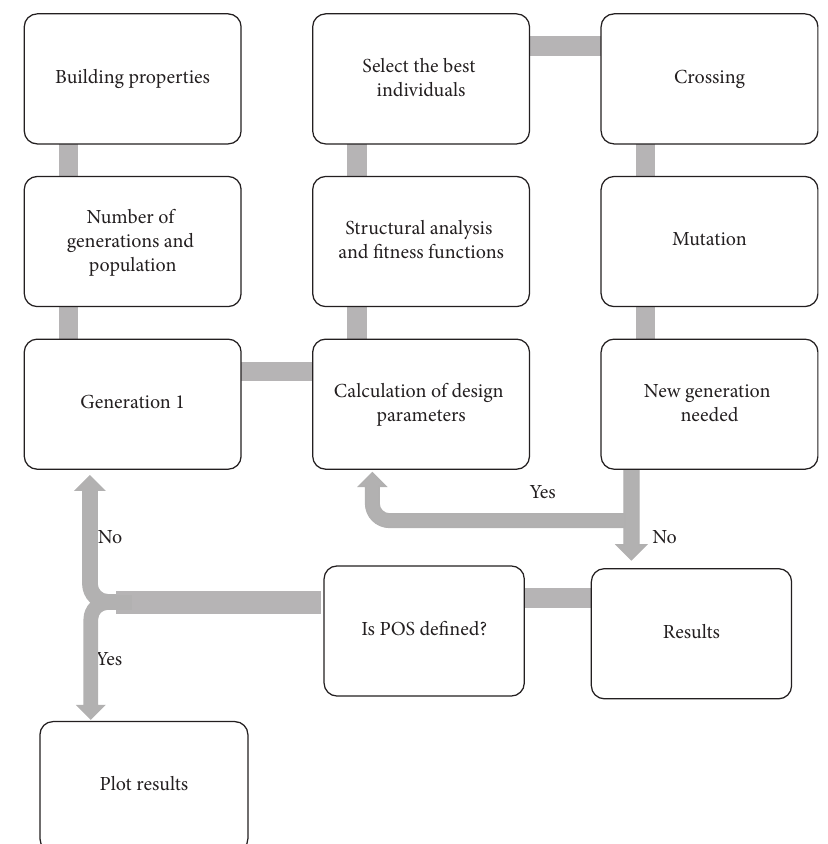
Figure 3: Flowchart used for the seismic design of the three-dimensional RC buildings